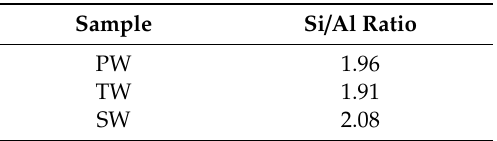
Table 5. Si / Al ratio of Si-O-Al linkage in di ff erent AAM mixes.